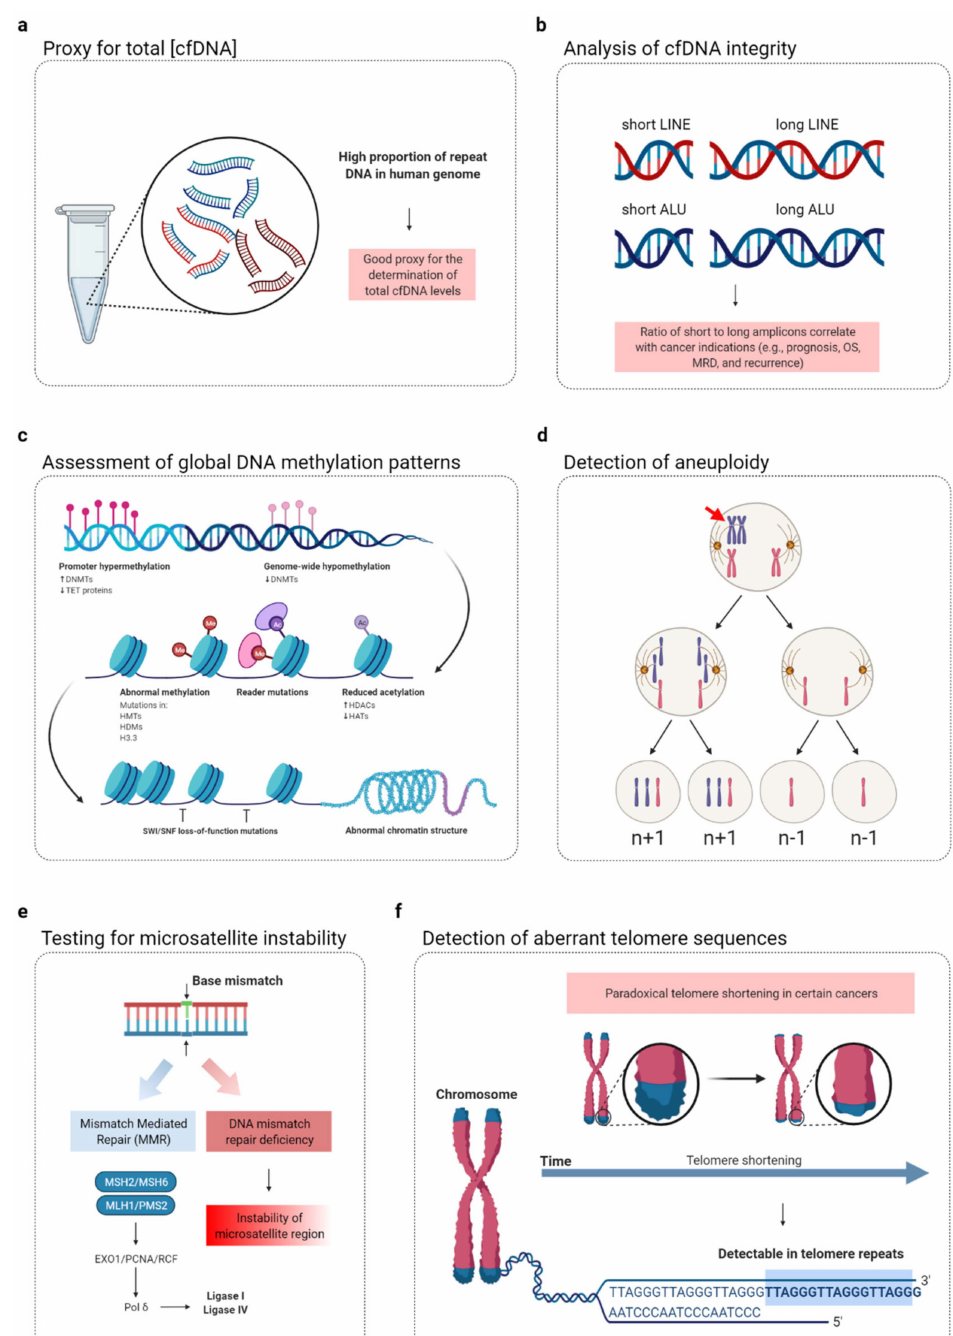
Figure 2. Potential applications of cfDNA repeat element analysis in cancer liquid biopsies. The repetitive element content of cfDNA can be used to characterize various features of cancer, including: ( a ) increased total cfDNA levels; ( b ) changes in cfDNA fragment size; ( c ) global DNA methylation changes; ( d ) aneuploidy; ( e ) microsatellite instability; and ( f ) aberrant telomeric sequences. This rep- resents an intriguing modality for the use of cfDNA to manage cancer patients and may complement many of the current and newly emerging cfDNA profiling